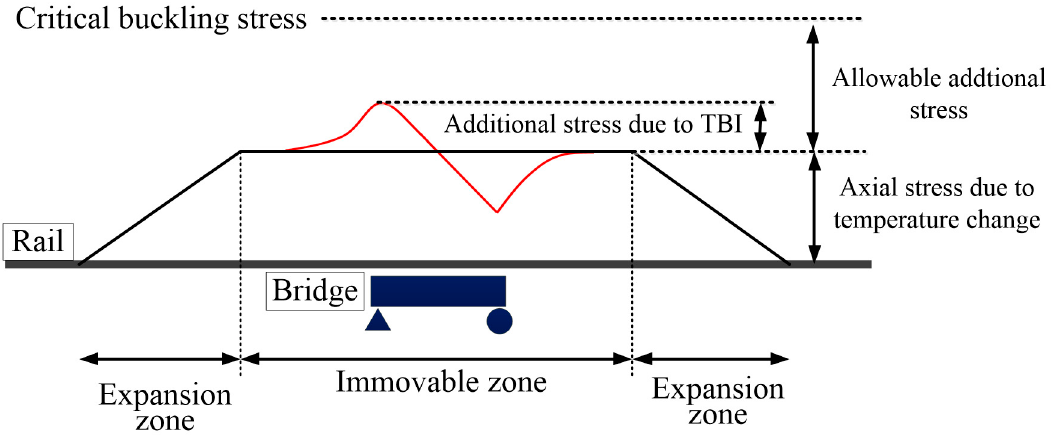
Figure 3. Axial force distribution of a CWR track on a bridge.